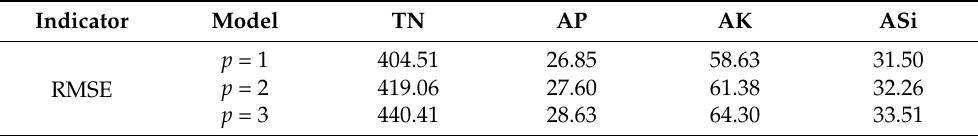
Table 3. Inverse distance weight analysis of N, P, K and Si in soils.